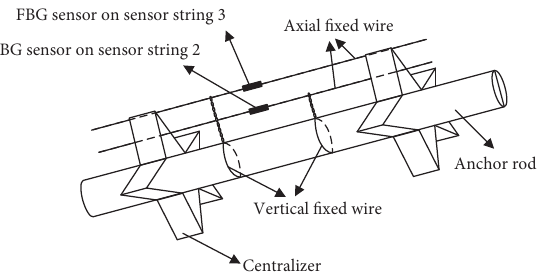
Figure 6: Fixation approach of sensor strings.